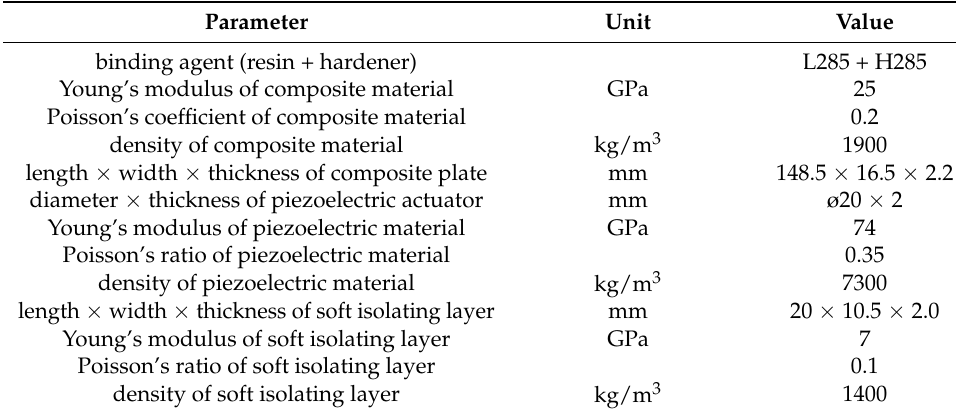
Table 1. Properties and geometric dimensions of the composite, piezoelectric and soft isolation layer